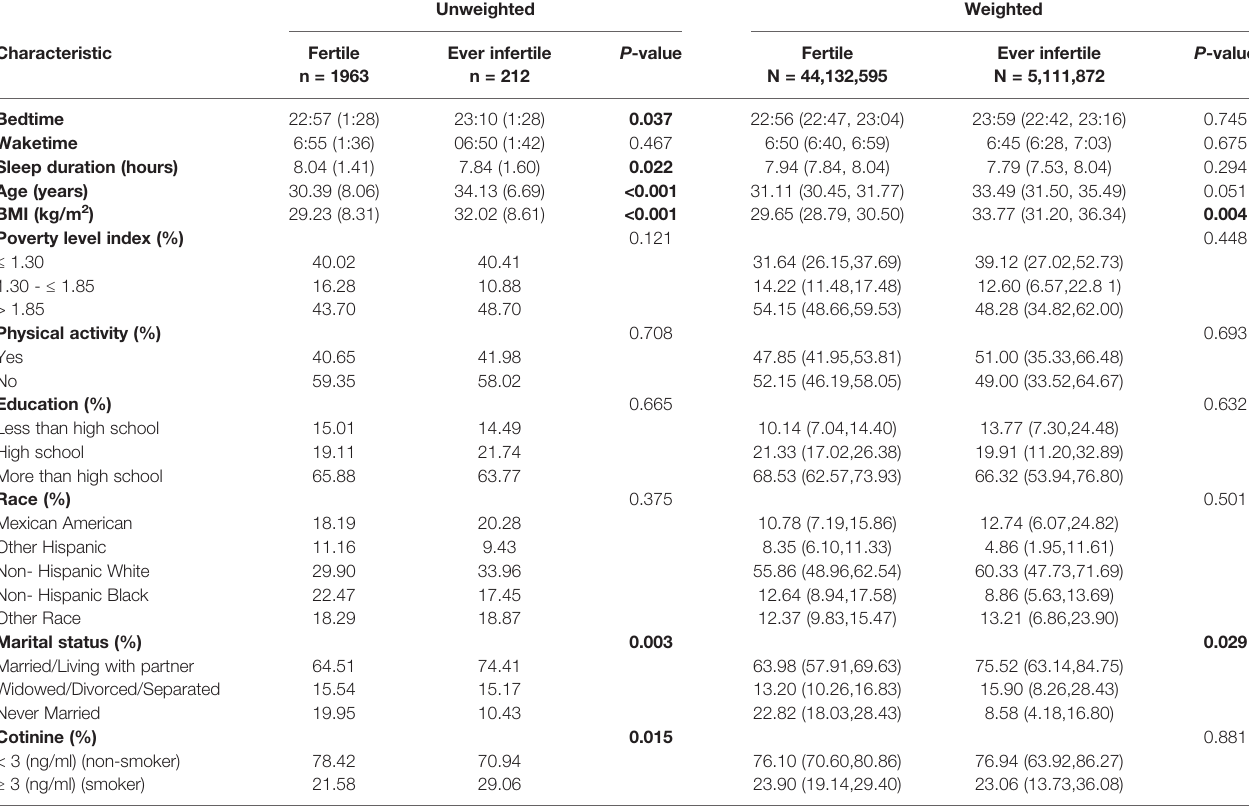
1. BMI, body mass index. 2. Data in the table: (Unweighted analyses) For continuous variables: mean (SD), P-value was by Student ’ s T test if they had normal distribution; median (Q1-Q3), P-value was by Mann – Whitney U test if they were non-normalvariables. For categorical variables: (%), P-value was by Chi-square test. (Weighted analyses) For continuous variables: survey-weighted mean (95% CI), P-value was by survey-weighted linear regression (svyglm); For categorical variables: survey-weighted percentage (95% CI), P-value was by survey-weighted Chi-square test (svytable). *Mann – Whitney U test for continuous variables. The bold values indicate a P-value